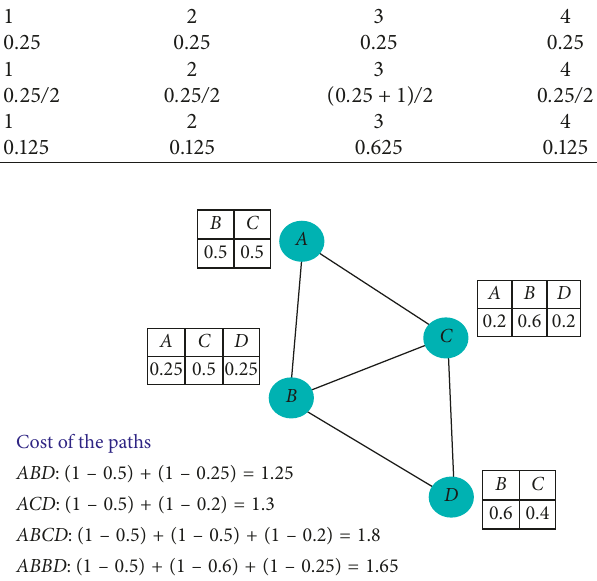
Figure 3: Calculus of path costs among the nodes A to D